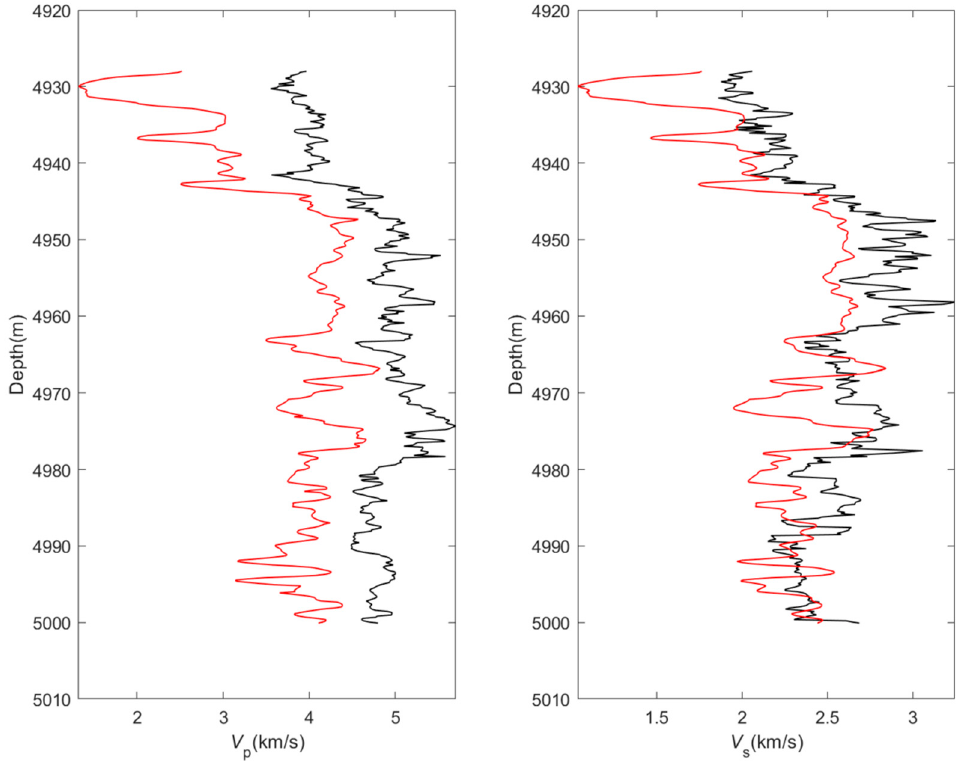
Figure 6. The prediction results of P-wave and S-wave velocities based on the Xu–White model (red is forecast speed, black is actual speed).